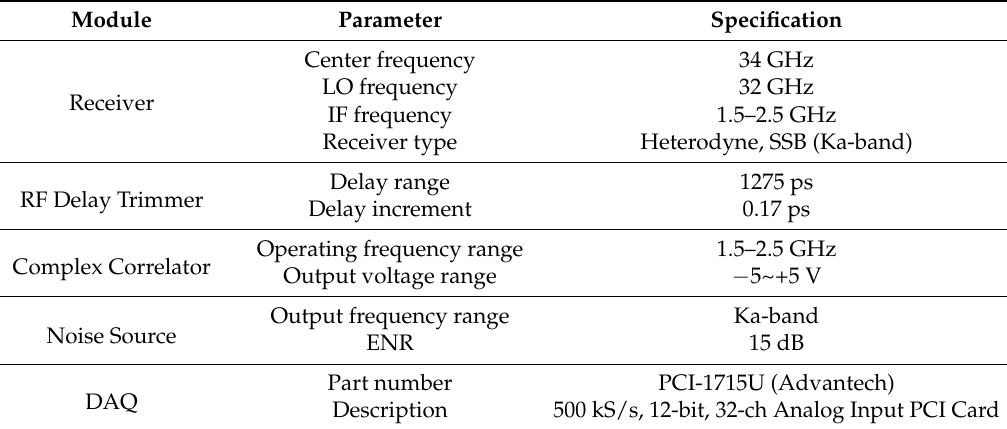
Figure 7. Photograph of the main parts in the experimental system. Table 1. Specifications of the main modules in the experimental system.